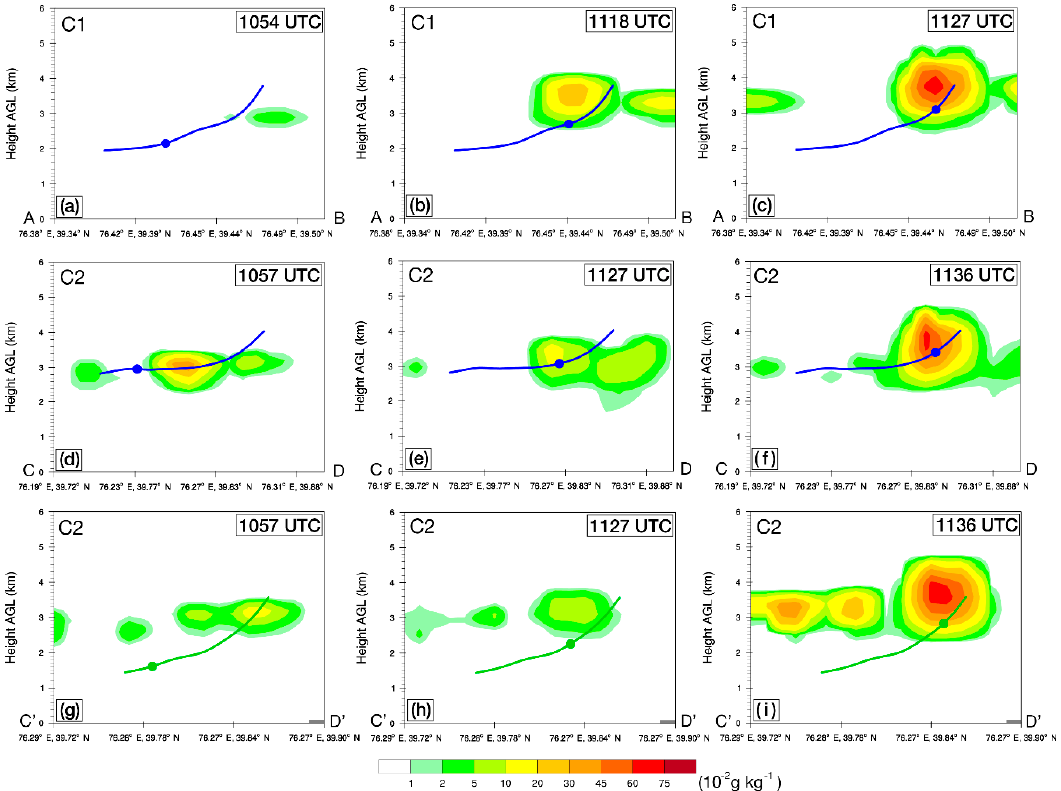
Figure 15. ( a – i ) The same as Figure 14a–i but for the vertical cross sections of hydrometeors (including cloud, graupel, rain, ice and snow) (shading, unit: 10 − 2 g kg − 1 ) on 23 June 2015. The specific time is shown in the upper right corner of each panel.